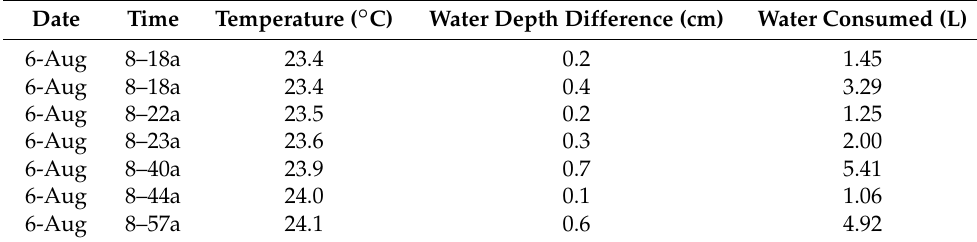
Figure 18. Recorded water temperature data with different day and time. Table 1. Data recorded in the SD